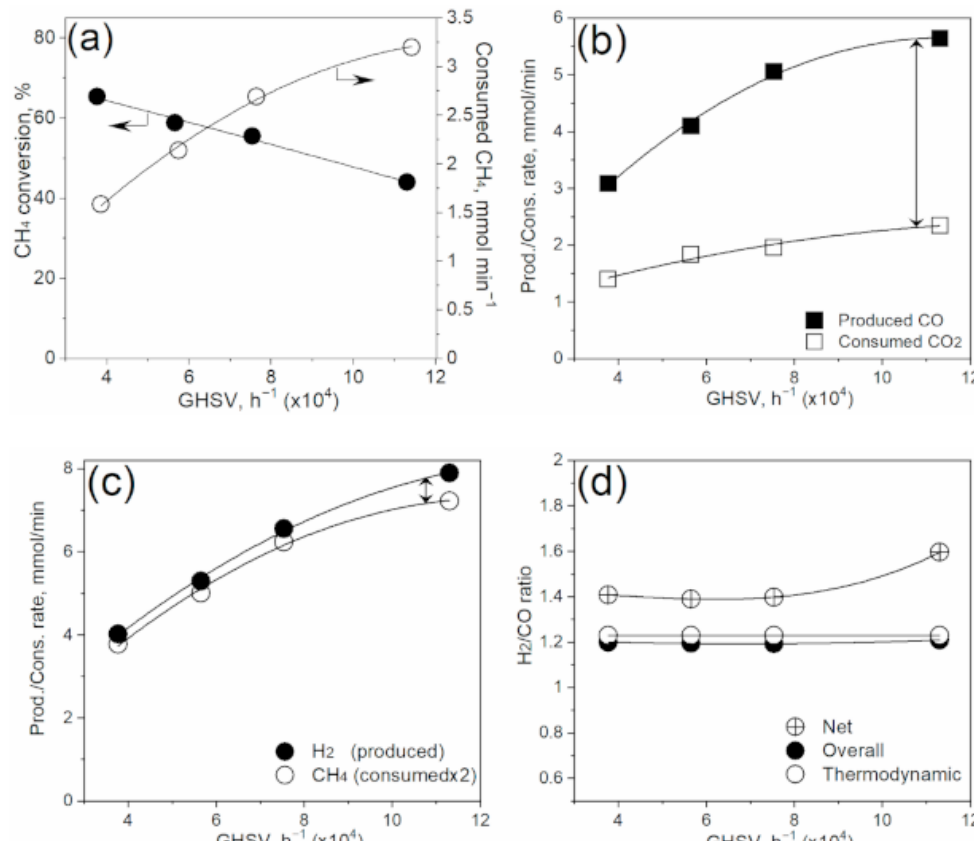
Figure 6. Changes in the reforming reaction of bio-syngas with 20% steam as a function of the gas space velocity at 850 ◦ C. ( a ) Methane conversion and consumed rate of methane; ( b ) Produc- tion/consumption rate for CO and CO 2 ; ( c ) Production/consumption rate for H2 and CH 4 ( × 2); ( d ) Changes in H 2 /CO